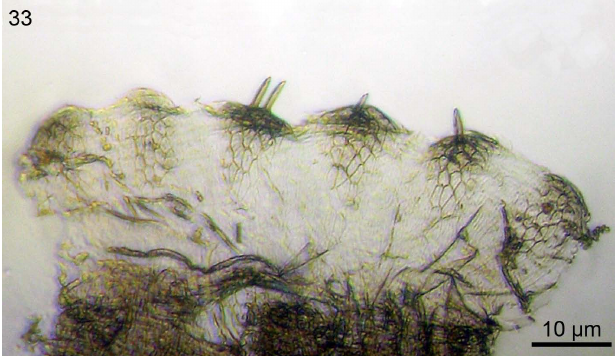
Fig 33. Enteric valve of Anoplotermes janus